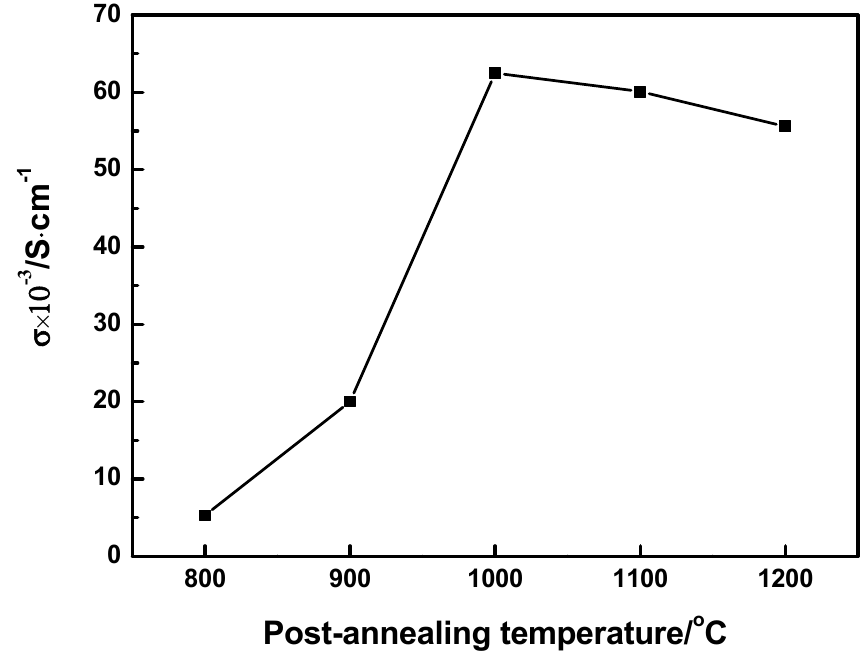
Figure 5. Conductivities of 0.2LSCO thin films at different post-annealing temperatures. The thermoelectric properties of 0.2LSCO thin films post-annealed at different temper- atures were measured by forming U-type TFTCs with Pt thin-film electrodes using a static calibration, and the variation curves of thermal voltages with temperature differences are shown in Figure 6. For the 0.2LSCO thin film annealed at 800 ◦ C, it was difficult to collect the thermal voltages from the voltmeter due to its poor conductivity and lower crystallinity, and its thermal voltage curve has not been marked in this figure. In addition, the thermal voltages have also not been marked for the 0.2LSCO thin film annealed at 1300 ◦ C, because of the interruption of electrical transport of the Pt electrode. For others, their thermal voltages increased first and then decreased with the post-annealing temperature. The results of average Seebeck coefficients of the 0.2LSCO thin films at different post-annealing temperatures are listed in Table 2. The maximum thermal voltage of 167.8 µ V/ ◦ C was obtained for the 0.2LSCO thin film annealed at 1100 ◦ C. The reproducibility of the mea- surements in this lab-made system can be achieved by fixing the place of the hot-junction in the furnace, as well as the temperature at the cold-end, for each